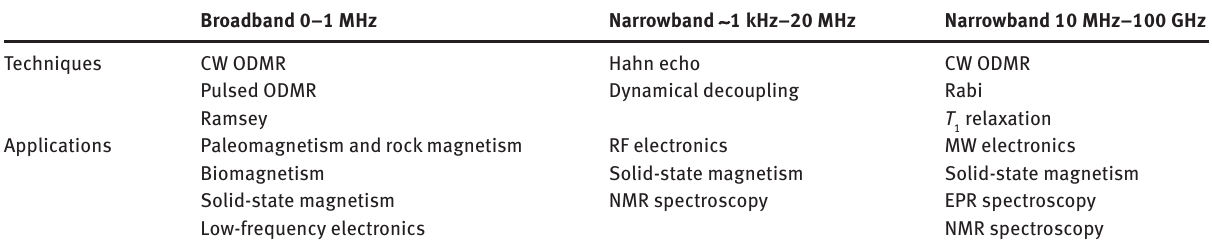
Table 3: QDM techniques and applications.